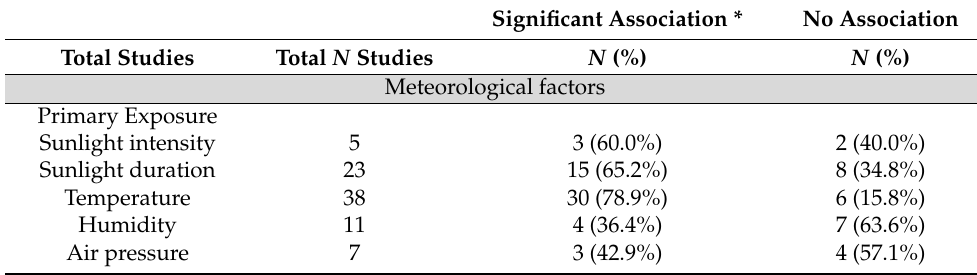
Table 2. Breakdown of exposures and analysis level of studies included in this